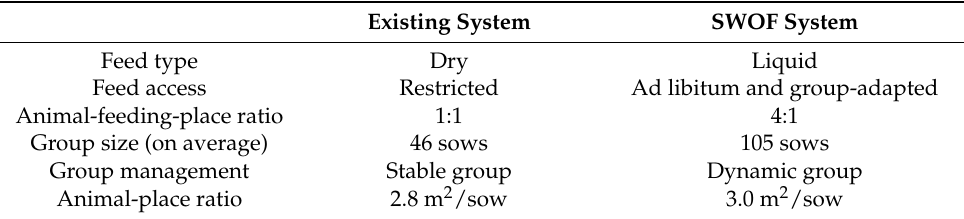
Existing System SWOF System Feed type